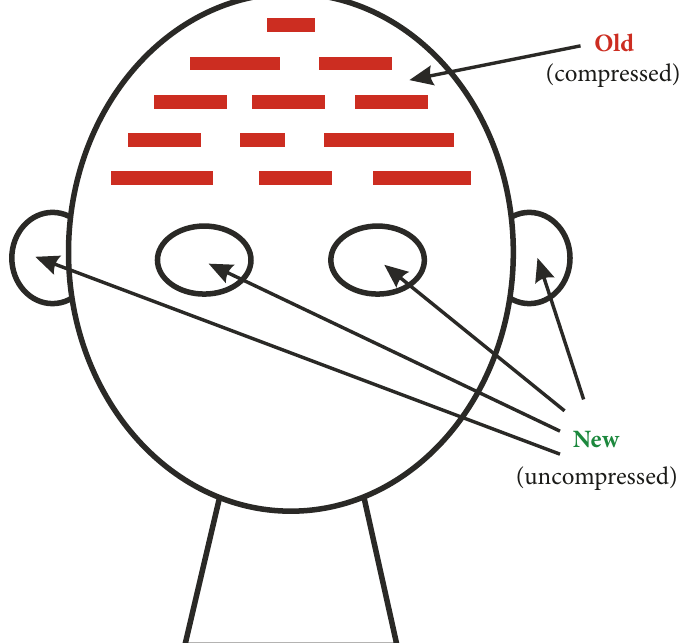
Figure 2: Schematic representation of the SP System from an “input” perspective. Reproduced with permission from Figure 1 in